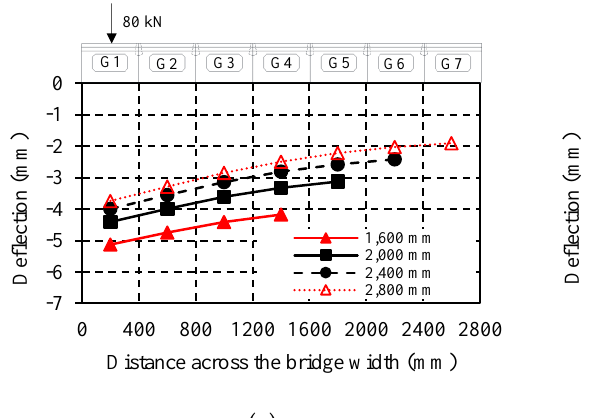
( b ) Figure 17. Mid-span LLMDFs for different bridge widths: ( a ) exterior girder G1 loaded and ( b ) in- terior girder G2 loaded. 5.4. Evaluation of LLMDFs The AASHTO LRFD-9 [17] specifies an approximate method to calculate the live load moment distribution factor (LLMDFs) using empirical formulas. The considered box girder in this study falls in category (g), which governs precast concrete box girders with or without transverse post-tensioning [17]. For this specific category, the LLMDFs for an interior girder were estimated using Equations (9) and (10) for one design lane, and two or more design lanes, respectively: